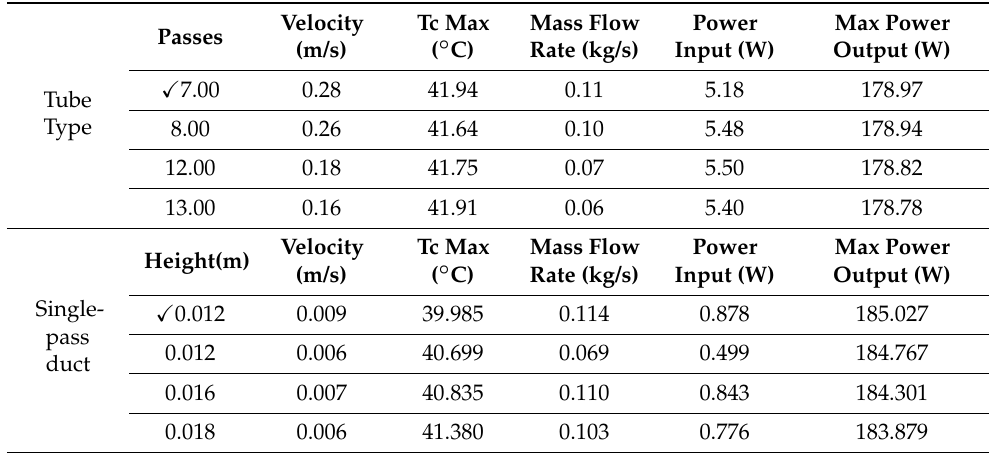
Table 3. Designed parameters of tube-type heat absorbers. (cid:88) —specify the optimized absorber parameters for analysis.